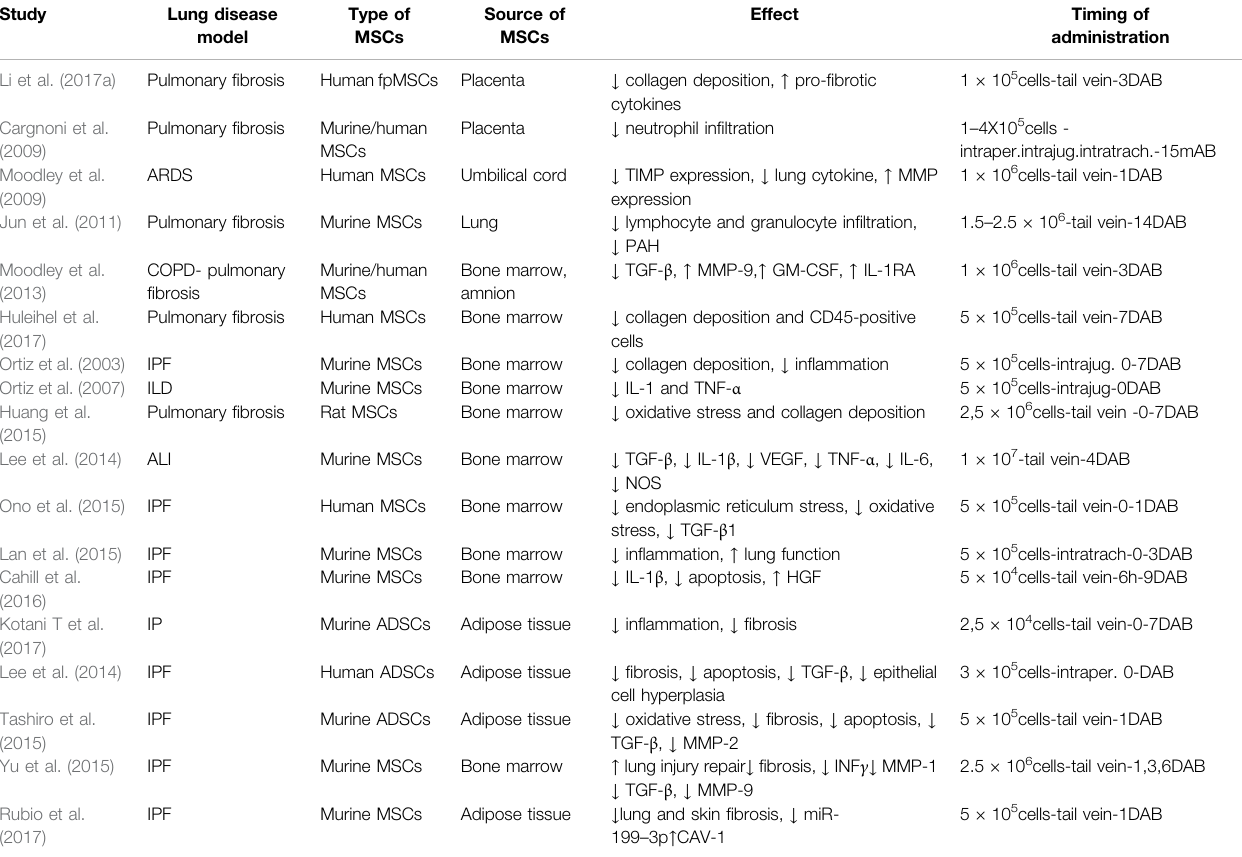
TABLE 2 | Pre-clinical applications of MSCs in lung diseases. DAB (cid:1) days after bleomycin administration.